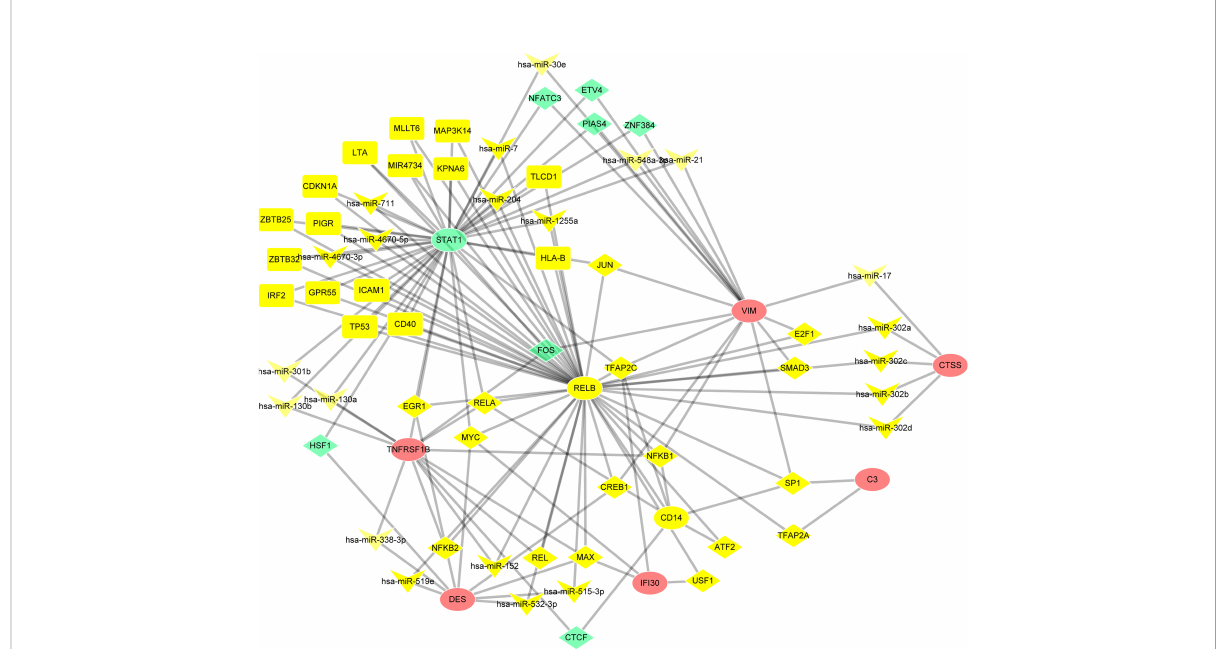
FIGURE 9 TF – miRNA coregulatory network. The round nodes are validated hub genes, the diamond nodes are TF genes, and the triangle nodes are miRNA